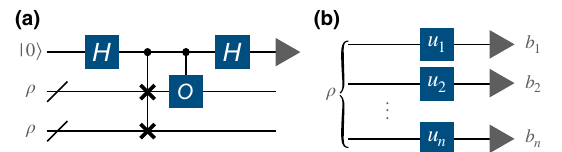
FIG. 1. Schematic representation of error mitigation with mul- tiple copies. (a) Performing an interferometry experiment, where H is the Hadamard gate, with a controlled- SWAP operation on two copies of state ρ together with a controlled- O operation on one of the copies enables measuring tr ( O ρ 2 ) . (b) The procedure in panel (a) can be replaced by randomized single-qubit measurements implemented by u i and postprocessing the results b i